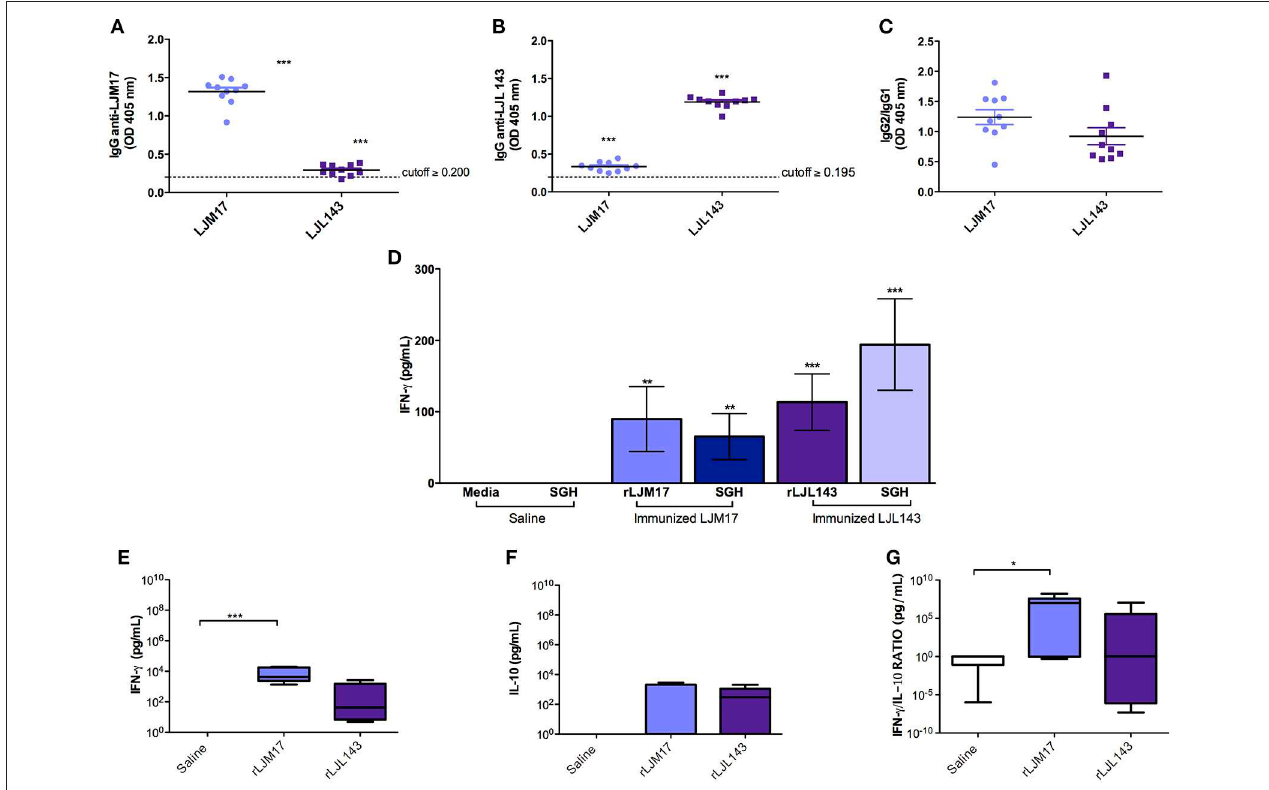
FIGURE 1 | Analysis of humoral and cellular immune response in immunized and control dogs. Beagles (n = 10 animals/group, total of 30 dogs) were immunized as described in the methodology section. Sera collected at T0 (15 days after the last immunization) were used to detect total IgG (A) anti-LJM17 or (B) anti-LJL143 and (C) specific IgG1/IgG2 subclasses. Dotted lines represent cutoffs obtained from sera of healthy dogs prior to immunization. PBMCs of immunized and control animals were stimulated with 4 µ g/mL of rLJM17 or rLJL143, and/or SGH of L. longipalpis , and supernatants were collected after 48h, then analyzed by ELISA to detect IFN- γ (D) . Luminex for the detection of IFN- γ (E) , IL-10 (F) and IFN- γ /IL-10 (G) . Statistical analysis was performed using the Kruskall-Wallis test with Dunns post-test (* p < 0.05, ** p < 0.005, *** p <